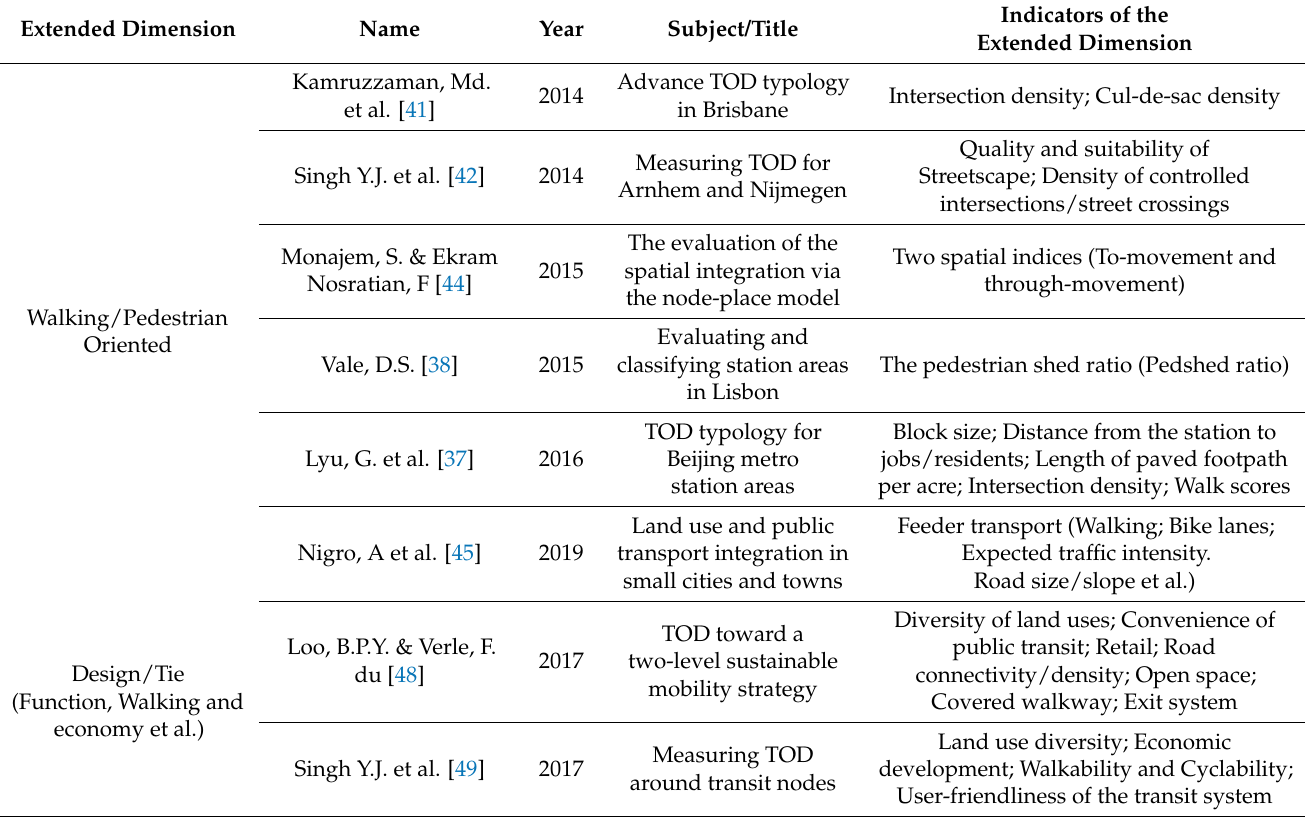
Table 1. Indicators of various extended